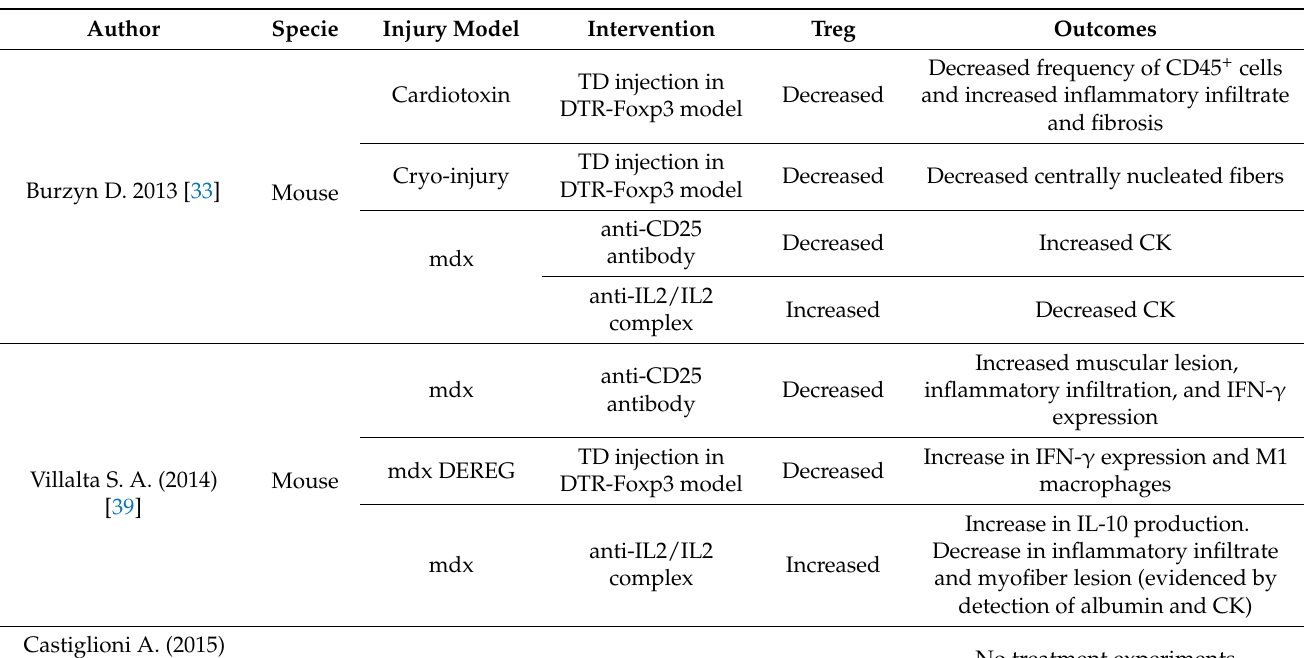
Table 3. In vivo interventions to modulate Treg